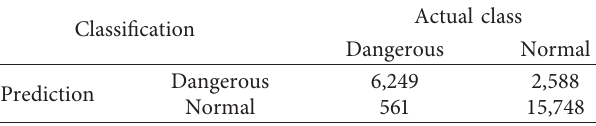
Table 4: Results (data acquisition cycle � 2Hz). Classification